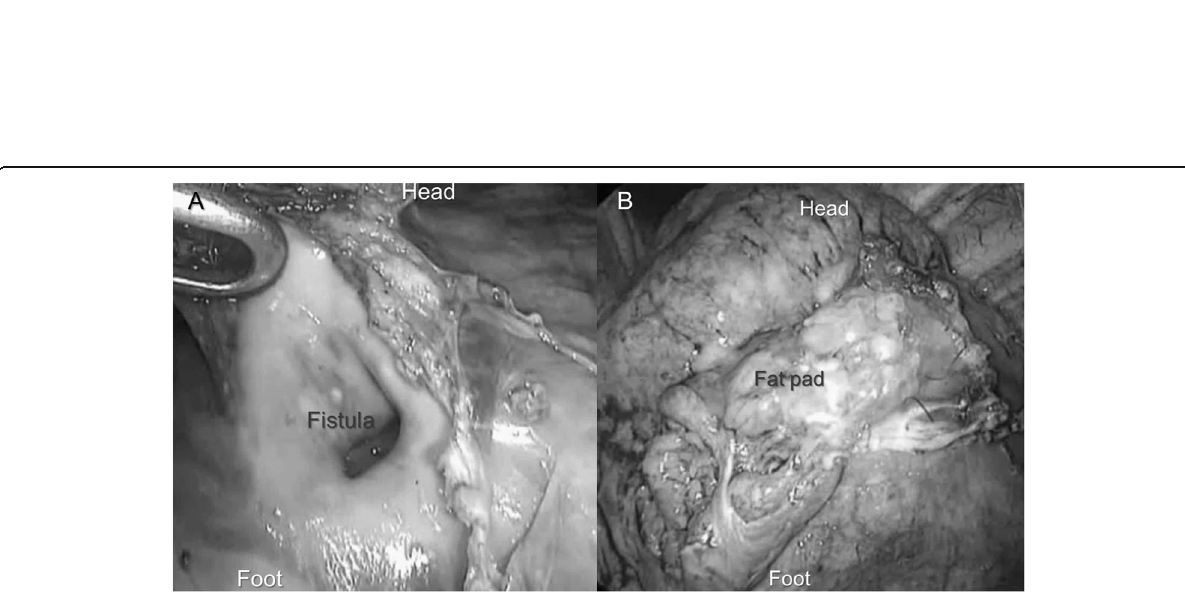
Fig. 2 Intraoperative findings (top, cranial side; left, ventral side). A huge fistula with a cavity was found in the LUL via left-side thoracoscopy ( a ). Via mini-thoracotomy assisted by thoracoscopy, the cavity was filled by a harvested pedicle pericardial fat pad (PFP), which was secured with sutures and fibrin glue ( b